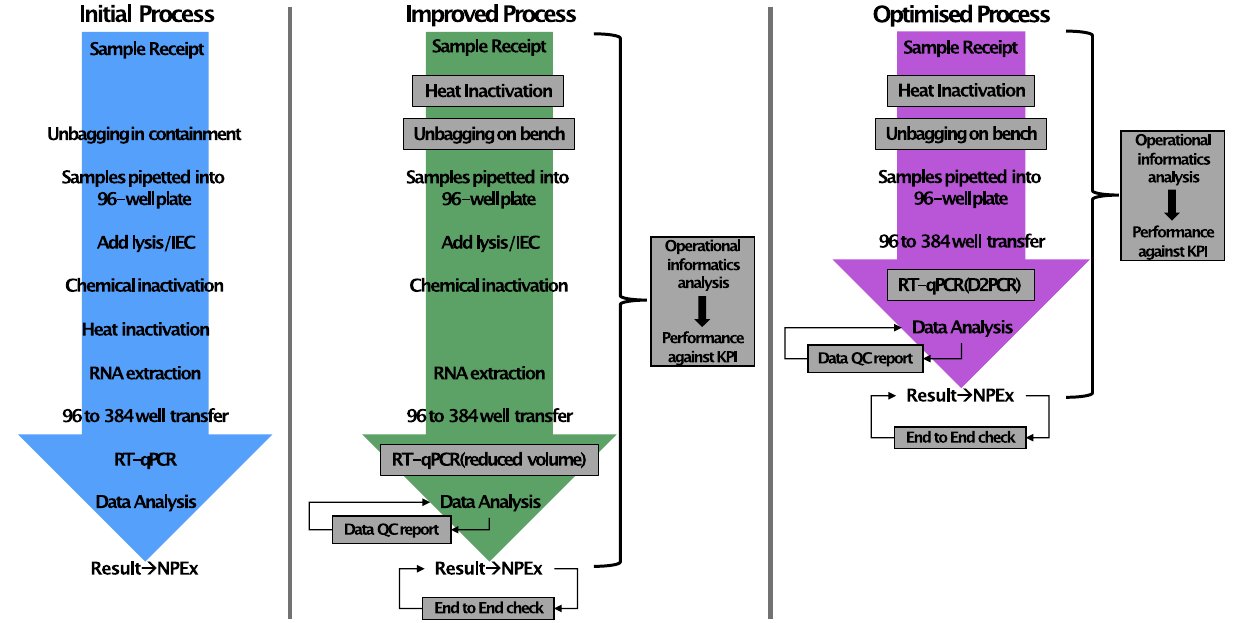
Figure 5. Evolution of the CCTC laboratory process. Evolution from initial standard process to fully optimised (incorporating both Heat Inactivation upon receipt and D2PCR format). Key changes from the initial process are shown in grey boxes—including physical laboratory steps along with alignment of data QC tools and continuous Operational informatics